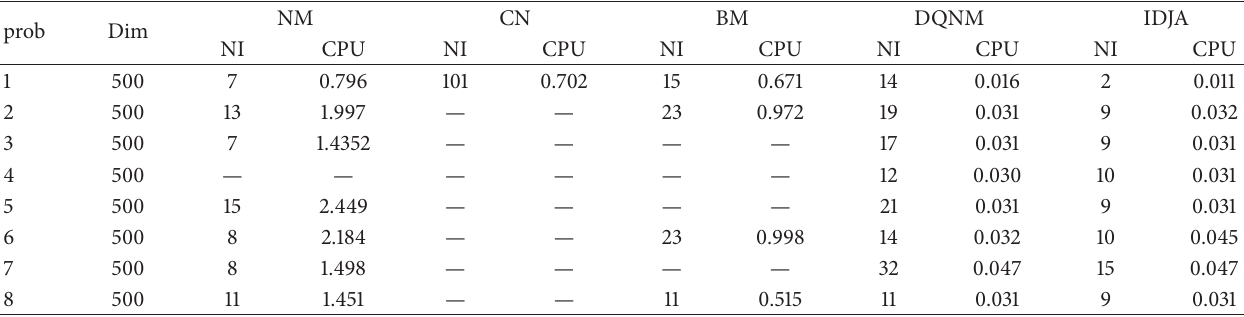
Table 4: Numerical results of NM, CN, BM, DQNM, and IDJA methods.